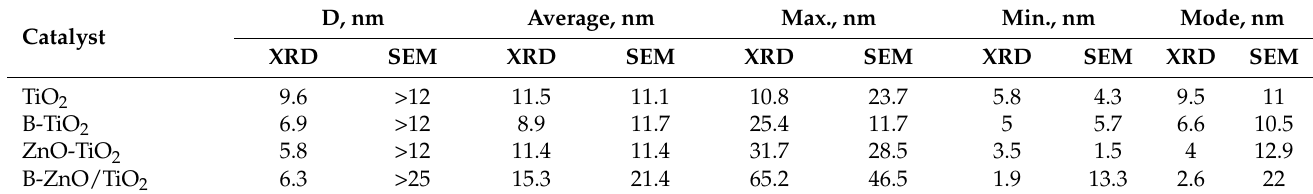
Table 2. Crystallite and particle size of pure TiO 2 , B-TiO 2 , ZnO-TiO 2 , and B-ZnO/TiO 2 .